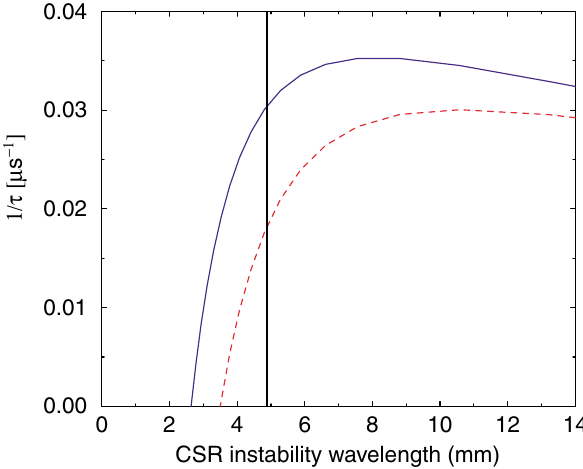
FIG. 4. (Color) The growth rate as a function of the CSR wavelength for the NLC main damping ring. The dashed curve is the result for the dipoles only, while the solid curve takes into account the contributions from the dipoles and the wig- glers. The vertical straight line is the approximate cutoff wave- length according to Eq. (10).